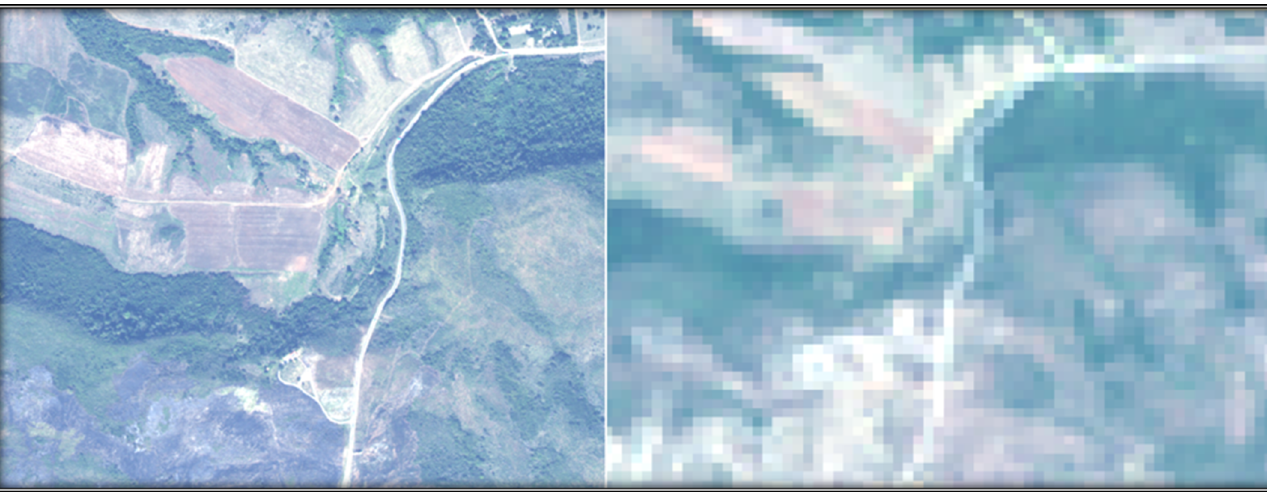
Figure A2. Difference in pixel size in WorldView-2 ( left ) and Landsat-8 ( right ) images.